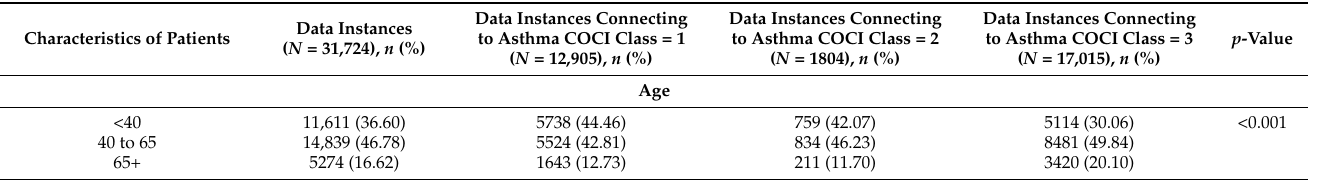
Table 4. The characteristics of the patients at the UWM from 2011 to 2018. Characteristics of